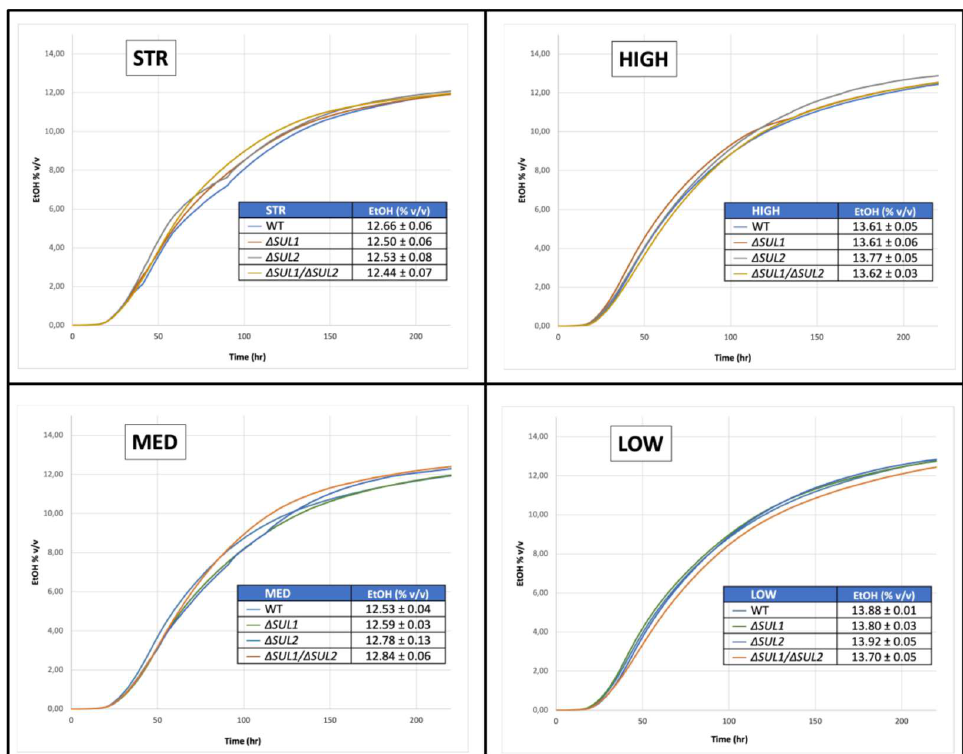
Figure 5. Fermentative performance of the winery yeast strains deleted for SUL1 and/or SUL2 genes. “Prosecco” natural must has been fermented using the indicated yeast strains (STR, HIGH, MED, and LOW), carrying parental (WT) or mutant alleles ( ΔSUL1, ΔSUL2, or ΔSUL1/ΔSUL2 ). In each panel, the fermentation kinetics and the final levels of ethanol (inset Table) are reported. Traces represent the average of four independent experiments (errors omitted for clarity), without statistically relevant differences between the yeast strains.